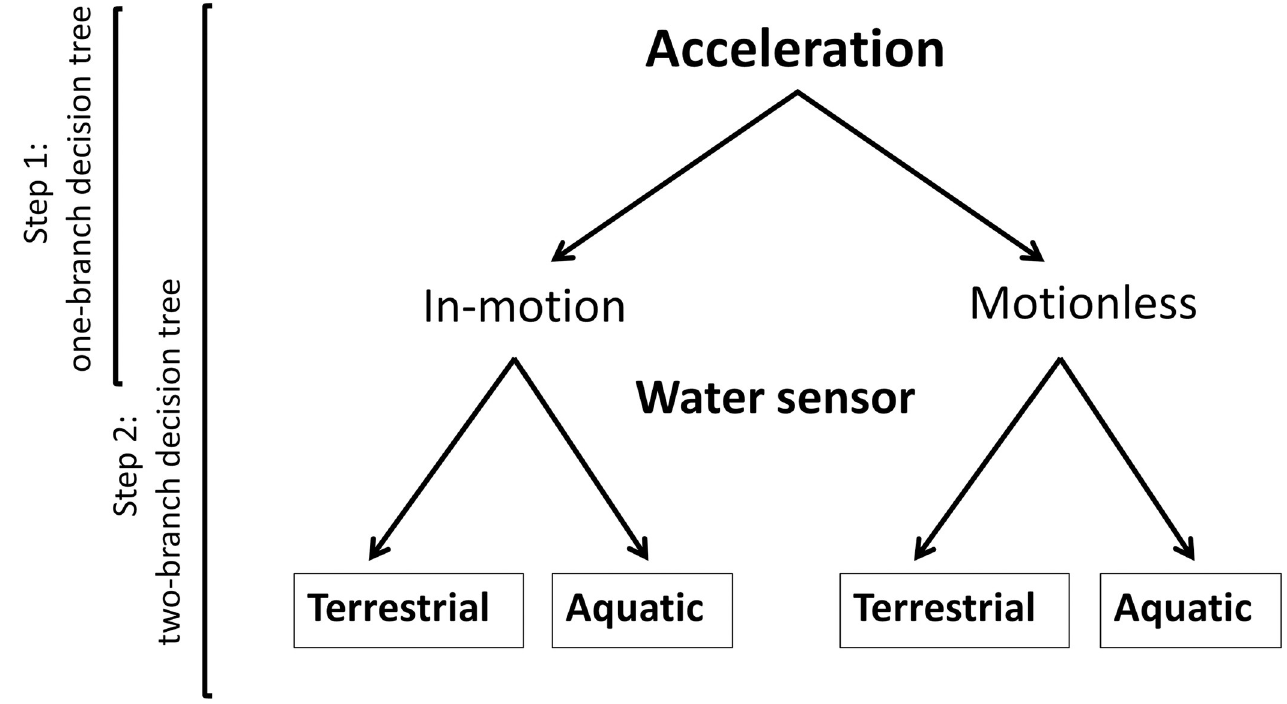
Fig 1. Two-step decision tree for classifying the main activities of freshwater turtles. Acceleration data are first binned according to activity level (Step 1) based on visual observation and acceleration thresholds, and then further classified according to habitat type based on a water conductivity sensor deployed in tandem with the accelerometer (Step 2). The same process was used to classify activity in both turtle species, resulting in four categories.